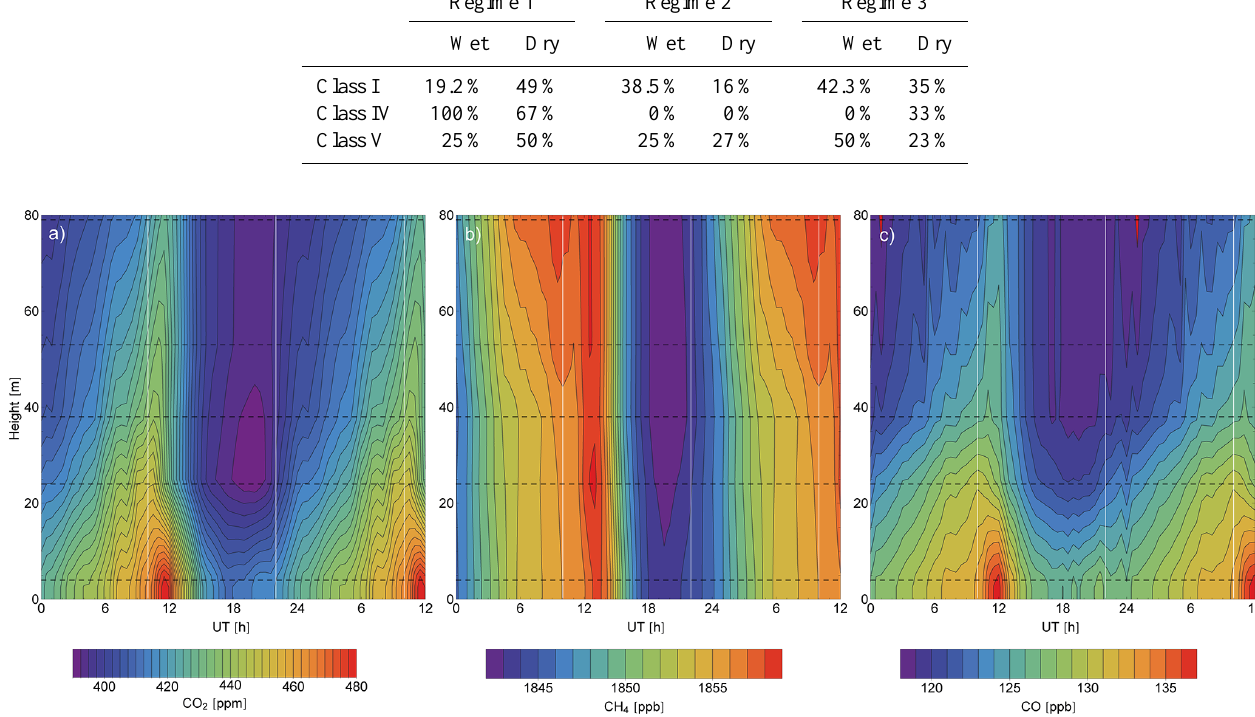
Figure 17. Diurnal cycle of (a) CO 2 , (b) CH 4 , and (c) CO. The CO 2 plot is computed from the measurements in January 2013, the CH 4 and CO plots from all available measurements until the end of 2014. Time is given in UT, with the first 12h repeated for clarity. The white vertical lines indicate the times of local sunrise (10:00UT) and sunset (22:00UT), respectively. Black dashed horizontal lines show the heights of the five